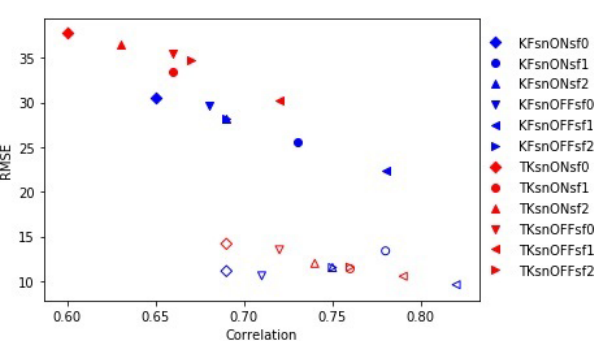
Figure 6. RMSE vs. CC for minimum sea level pressure in hPa (filled) and for maximum winds in ms − 1 (not filled) for the sensi- tivity